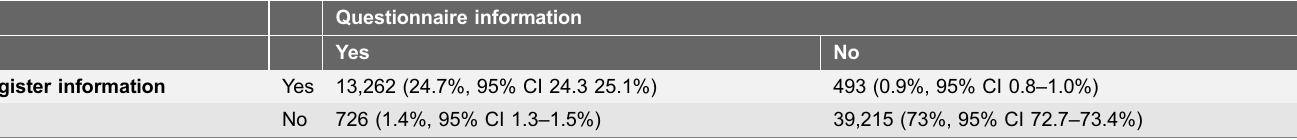
Table 4. 2 6 2 table of tube insertion information in 53,696 (missing 192) children from the Danish National Birth Cohort, 1996–2005. Questionnaire